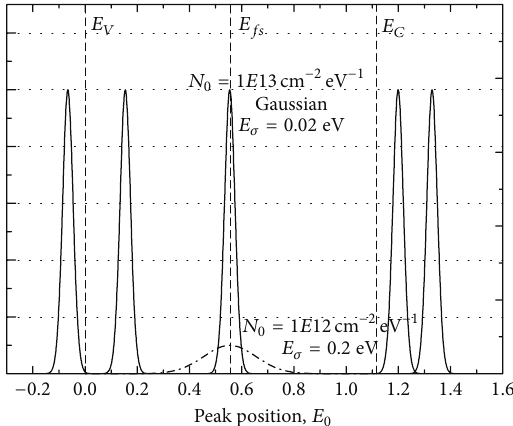
Figure 2: High and low Gaussian distributions are 𝐸 𝜎 = 0.02 and 0.2, which have 1 × 10 13 cm −2 eV −1 and 1 × 10 12 cm −2 eV −1 interface traps concentration, respectively. The peak position of Gaussian distribution ranges from 𝐸 V to 𝐸 𝑐 and extends beyond the forbidden band.